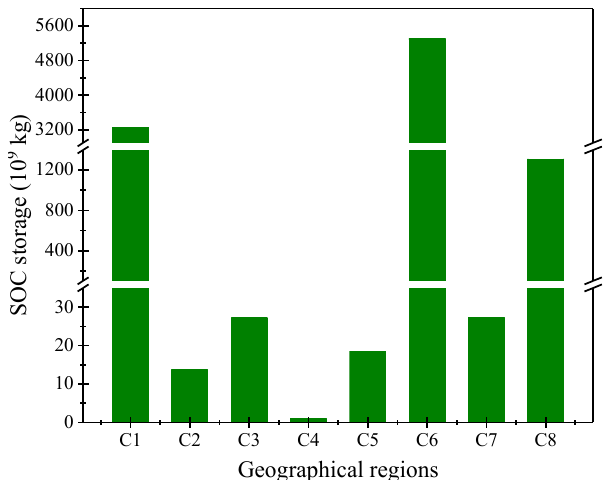
Figure 3. SOC storage in eight geographic regions.